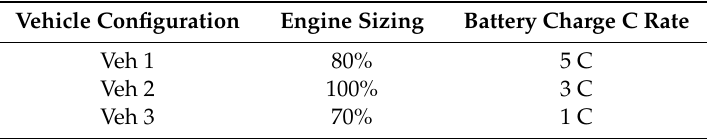
Table 1. Vehicle configuration